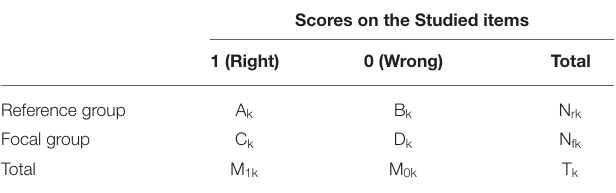
TABLE 1 | 2 × 2 × K contingency table.